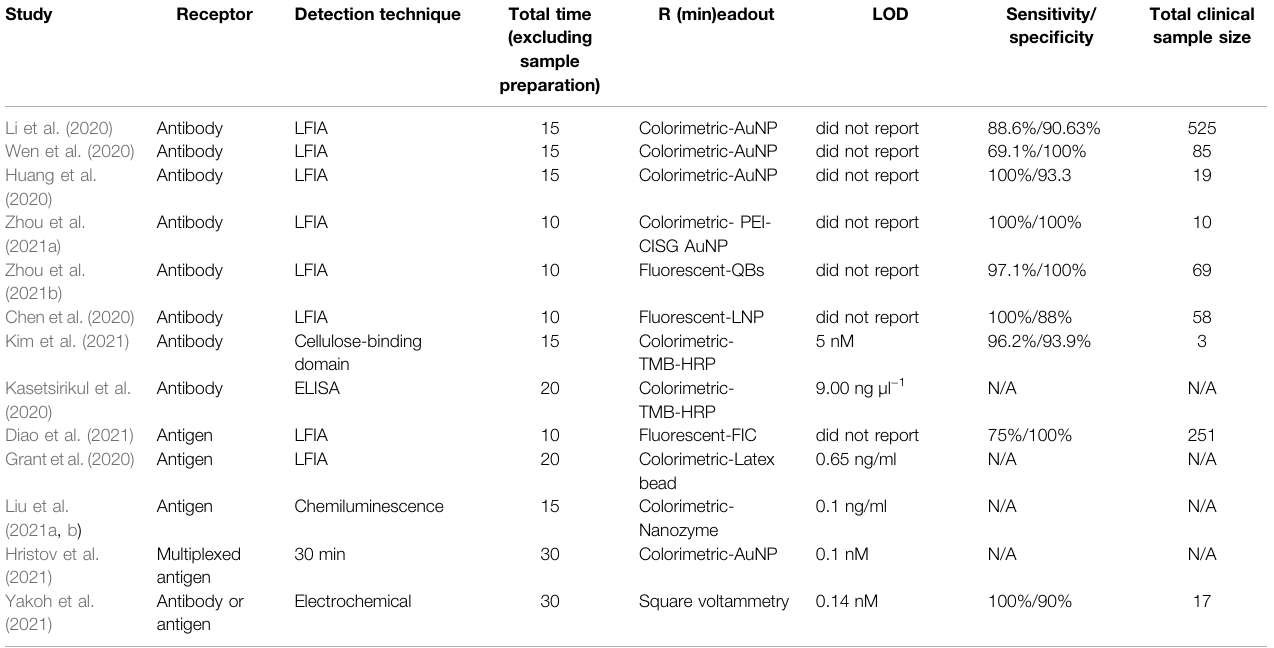
TABLE 1 | Existing paper-based immunoassay